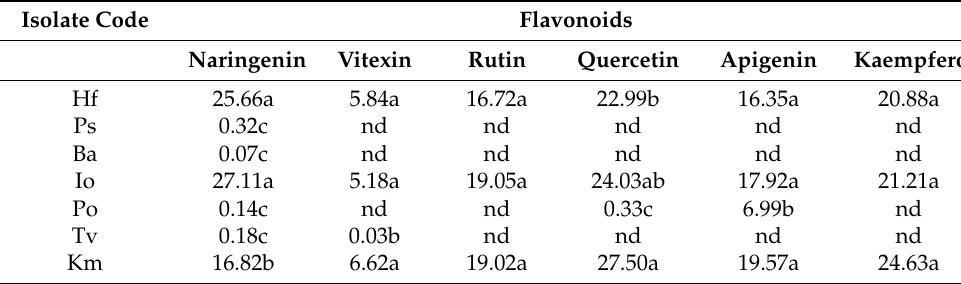
Table 3. The flavonoids concentration of 7 fungal isolates (mg/kg DM in mycelium).